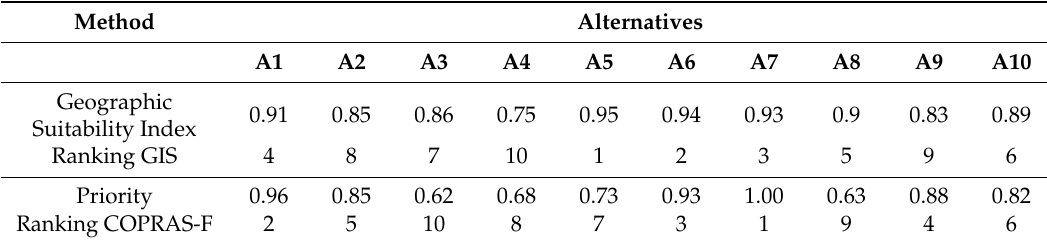
Table 11. GIS-MCDM and COPRAS-F